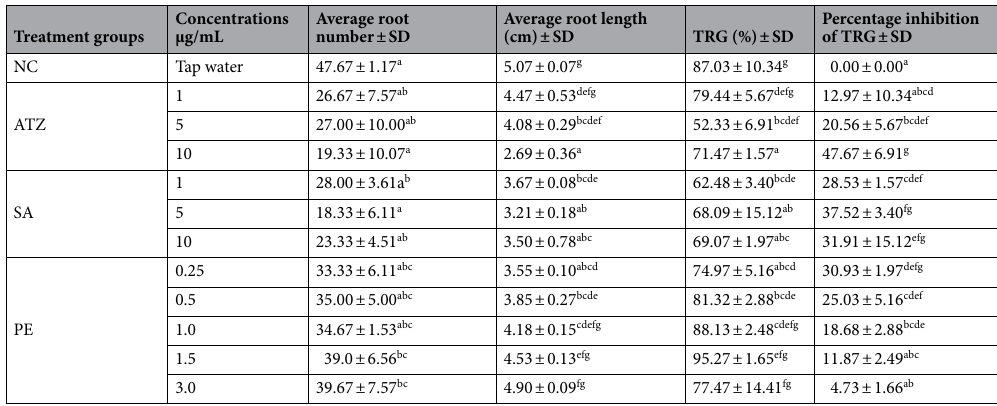
Table 3. Effects of atrazine, sodium azide and plant extract on Allium cepa root growth. NC negative control, ATZ atrazine, SA sodium azide, TRG total root growth. Data are mean ± SD of three replicates. Different alphabets (a, b, c, d, e, f and g) are significantly different at (p < 0.05), as determined by Tukey HSD test.